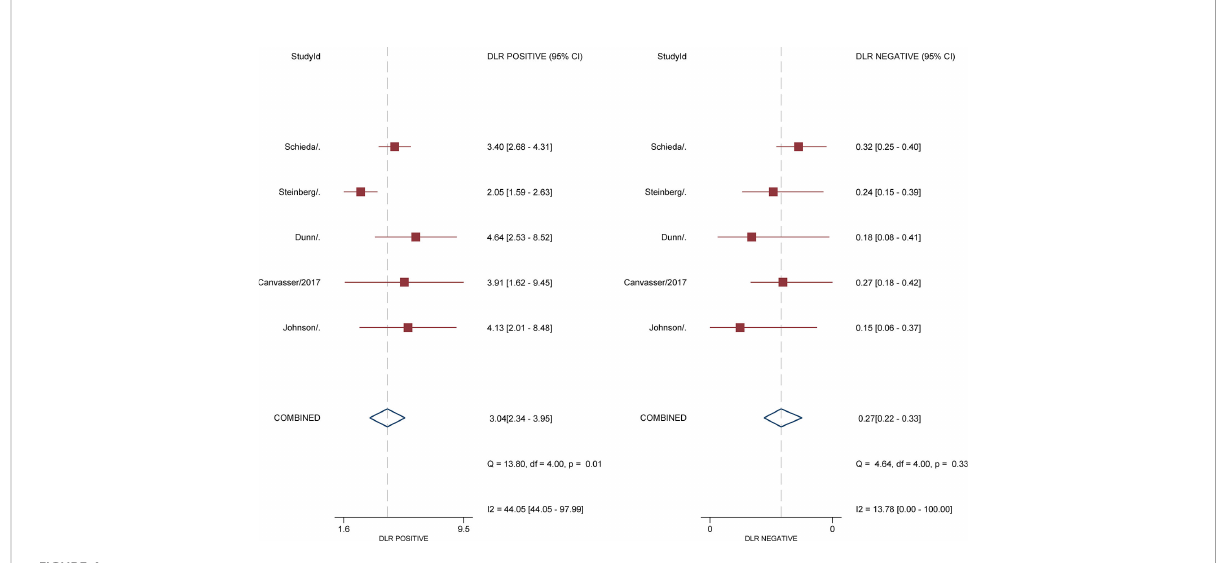
FIGURE 4 Coupled forest plot of pooled negative and positive likelihood